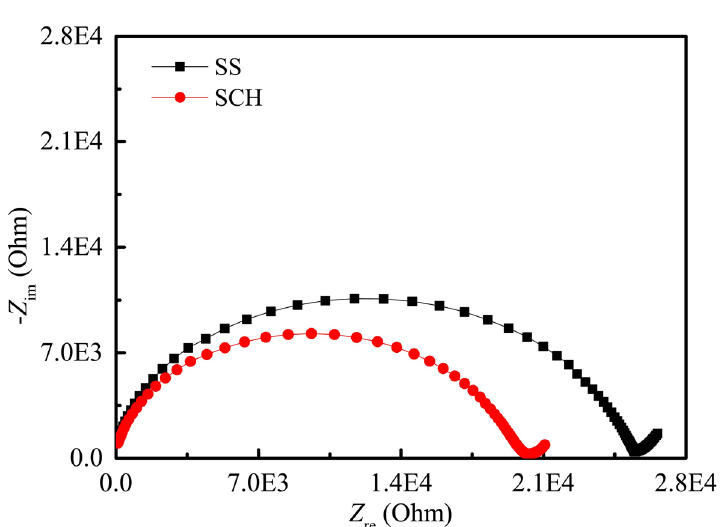
Figure 12. Nyquist plots of oven-dried samples evaluated by two-point